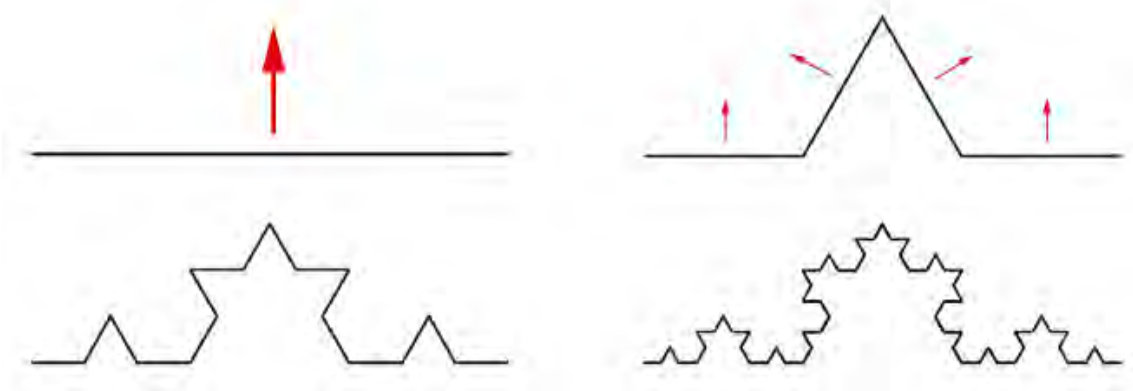
Figure 1. Basic steps of Von Koch